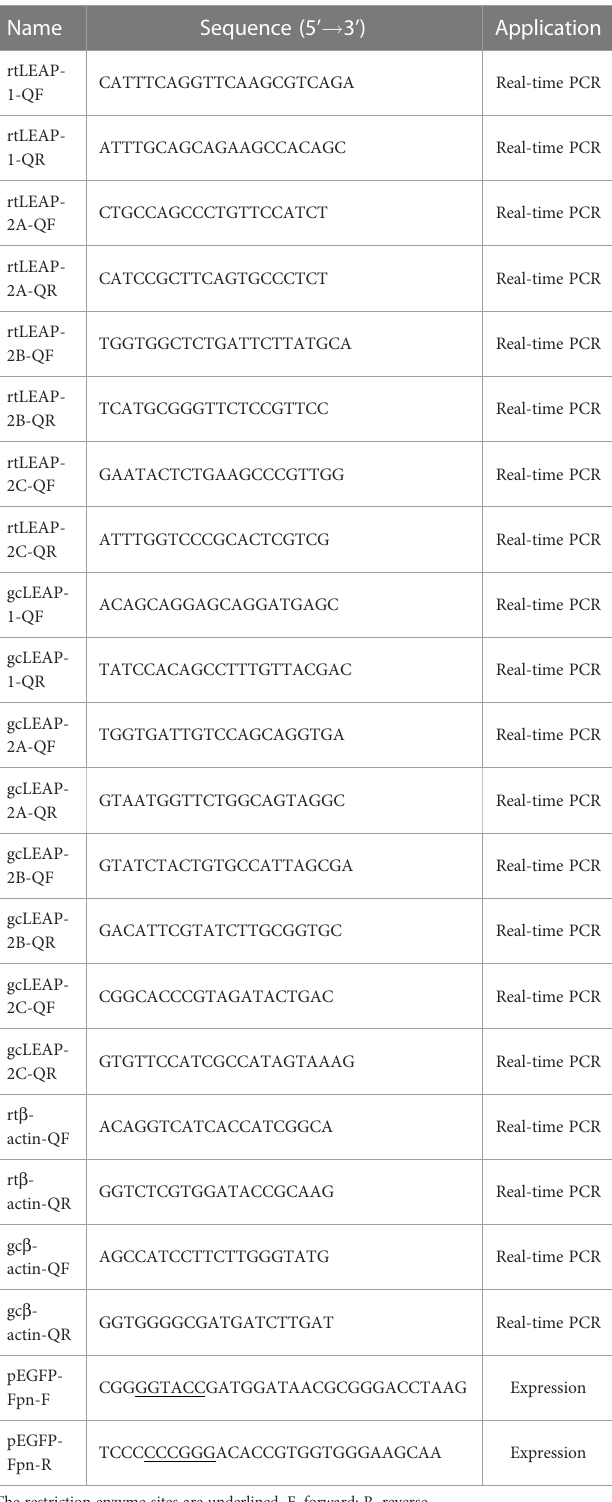
TABLE 2 Primers used in this